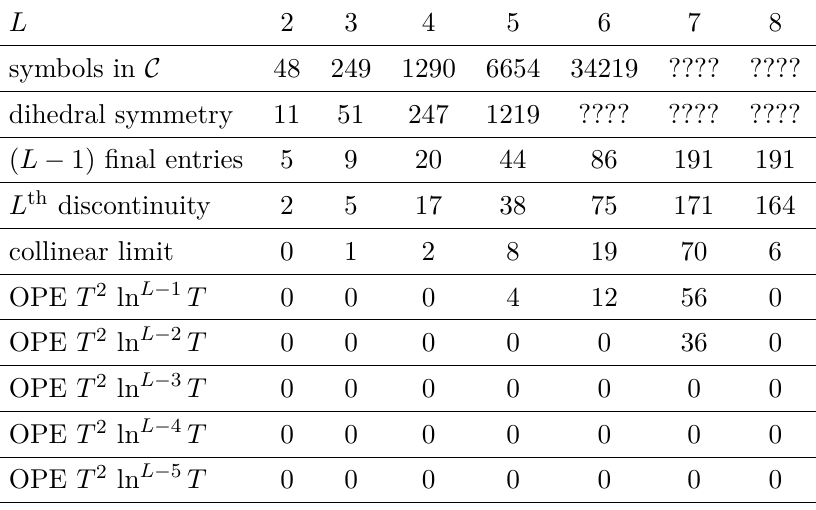
Table 6. Number of parameters left when bootstrapping the form factor E ( L ) at L -loop order in the function space C at symbol level, using all the conditions on the final ( L − 1) entries, which can be deduced at ( L − 1)